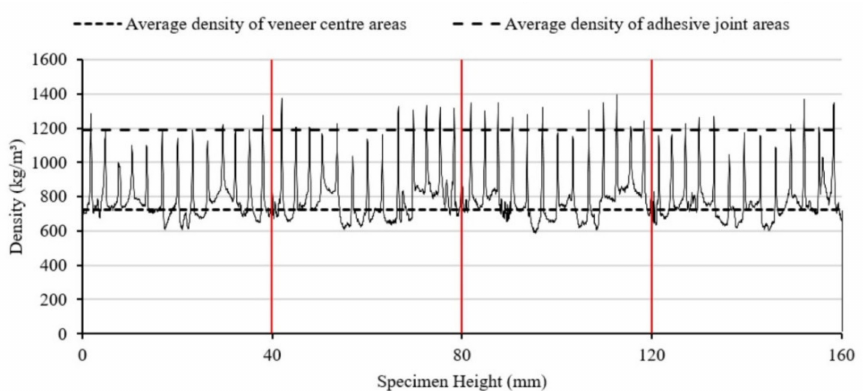
Figure 2. Density profile of a laminated beech veneer lumber test specimen (Specimen 1) based on all values measured. Dotted horizontal lines represent average density values for areas of the adhesive joints and veneer centres. Red vertical lines highlight the adhesive joints between the individual laminated veneer boards at 40, 80 and 120